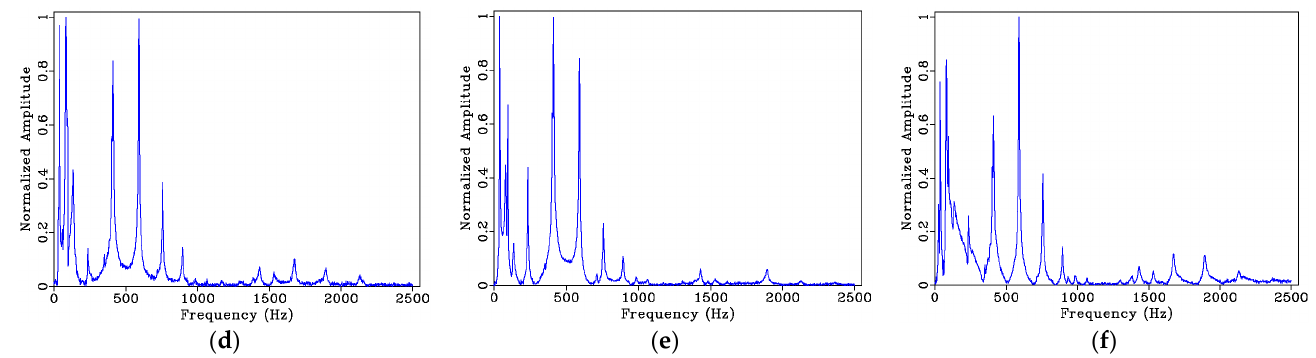
Figure 12. Normalized pre-damage acceleration response signal spectra (frequency domain): ( a ) un8-2; ( b ) un8-8; ( c ) un8-14; ( d ) un14-2; ( e ) un14-8; ( f ) un14-14.